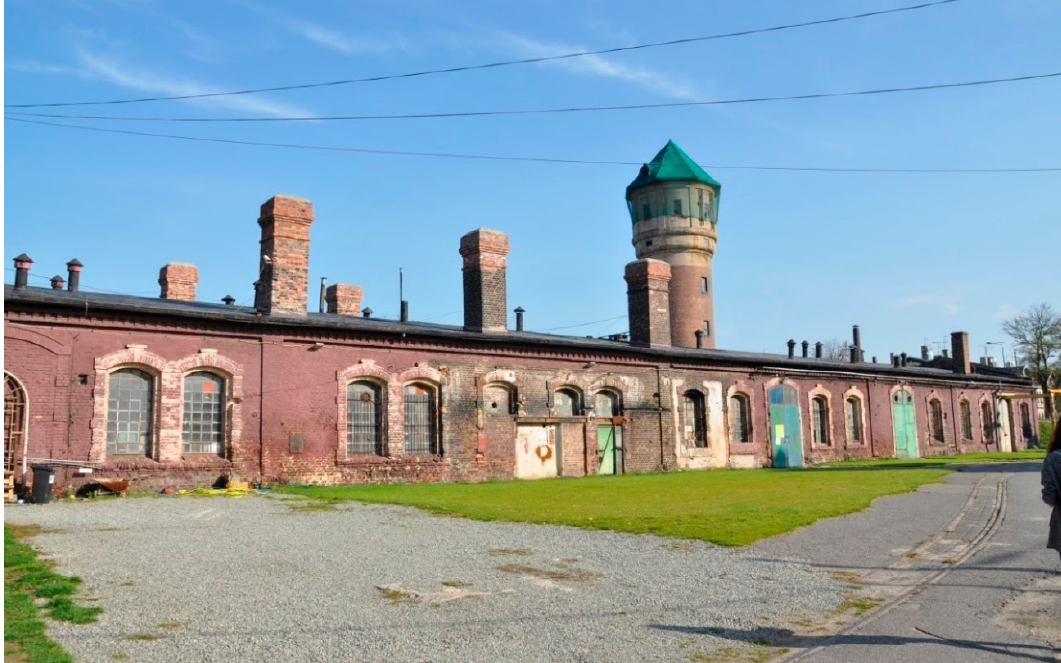
Figure 3. The mechanical workshop and smithy—an exhibition about the history of industry in Upper Silesia (photo: A. Ostr ę ga).